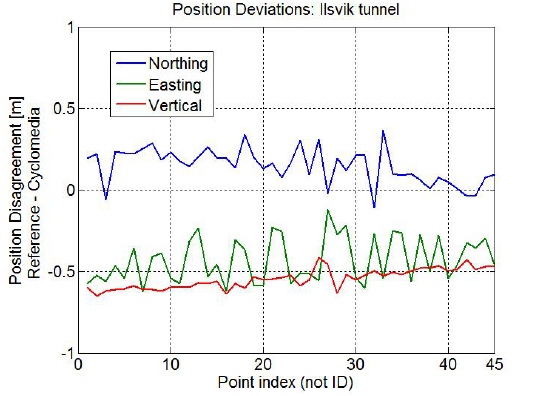
Figure 11: Differences in position between Cyclomedia based and survey based in-tunnel positioning, Ilsvik